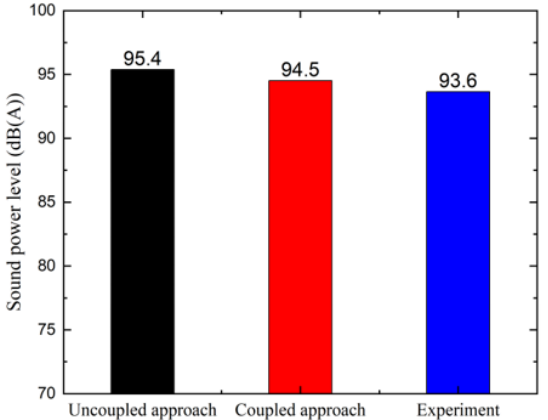
Figure 32. The overall sound power level comparison between the two simulation approaches and the experimental value.